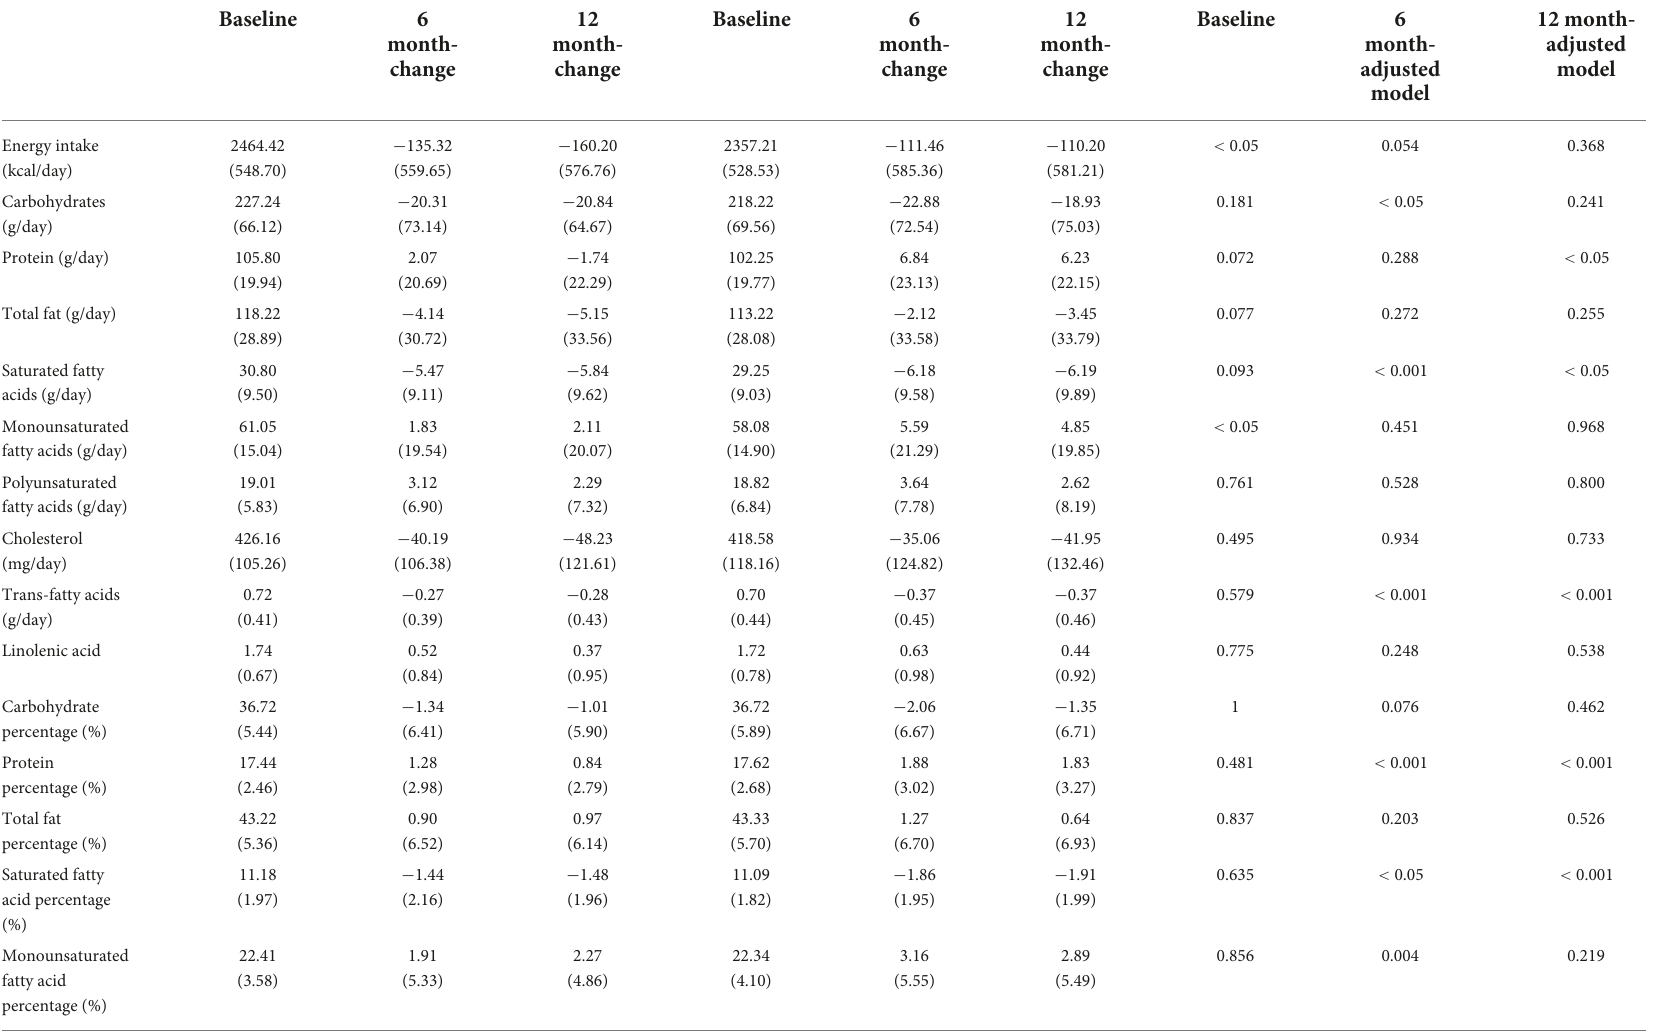
TABLE 2 Baseline and differences at 6-and 12-month follow-ups (mean and standard deviation) stratified in the control and intervention groups in the consumption of key food items and dietary parameters between the control and intensive group adjusted for the baseline